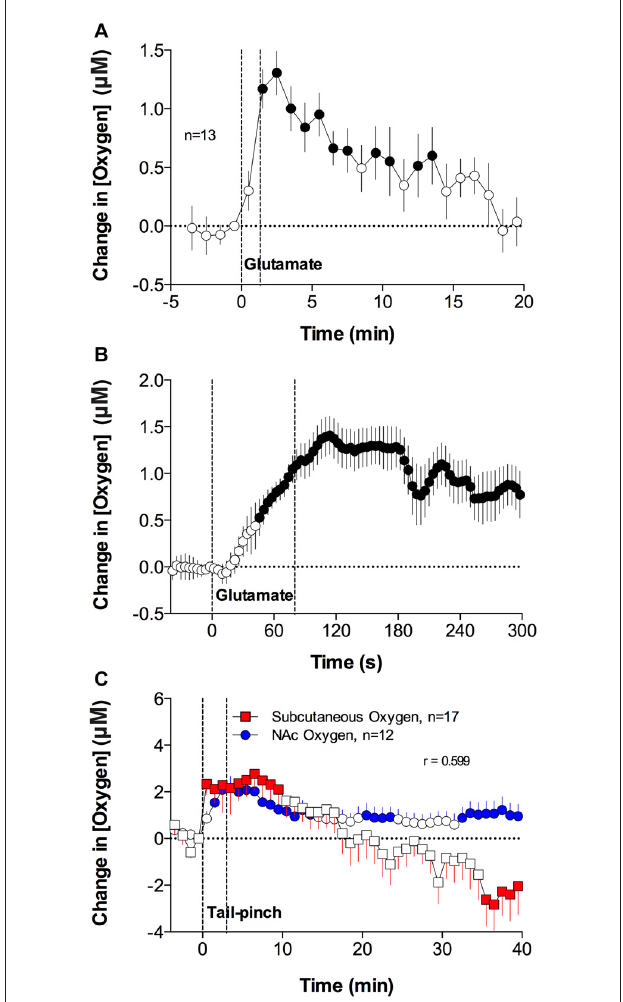
FIGURE 2 | Mean ( ± SEM) changes in NAc oxygen levels induced by local microinjections of glutamate (GLU) near the oxygen-detecting site (A,B) . Comparison of changes in oxygen levels in the subcutaneous space and NAc induced by 3-min tail-pinch (C) . Durations of GLU microinjection (A,B) and tail-pinch (C) are shown as vertical dotted lines. n indicates the number of averaged tests. The technical details of combined neurochemical recording and drug microinjections have been presented elsewhere (Kiyatkin and Lenoir, 2012; Solis et al., 2017a). In brief, L-GLU (as a monosodium salt) was delivered in 1–5 mM solutions (0.2–0.5 µ l) via small, stainless steel tubing (120 µ m internal diameter), with its tip located within ∼ 200–400 µ m from the oxygen recording site. In experiments assessing oxygen changes in subcutaneous space, cannulae were implanted subcutaneously in the medio-frontal area of the rat’s head. Values significantly different from baseline are shown as filled symbols. Original data were published in Solis et al.